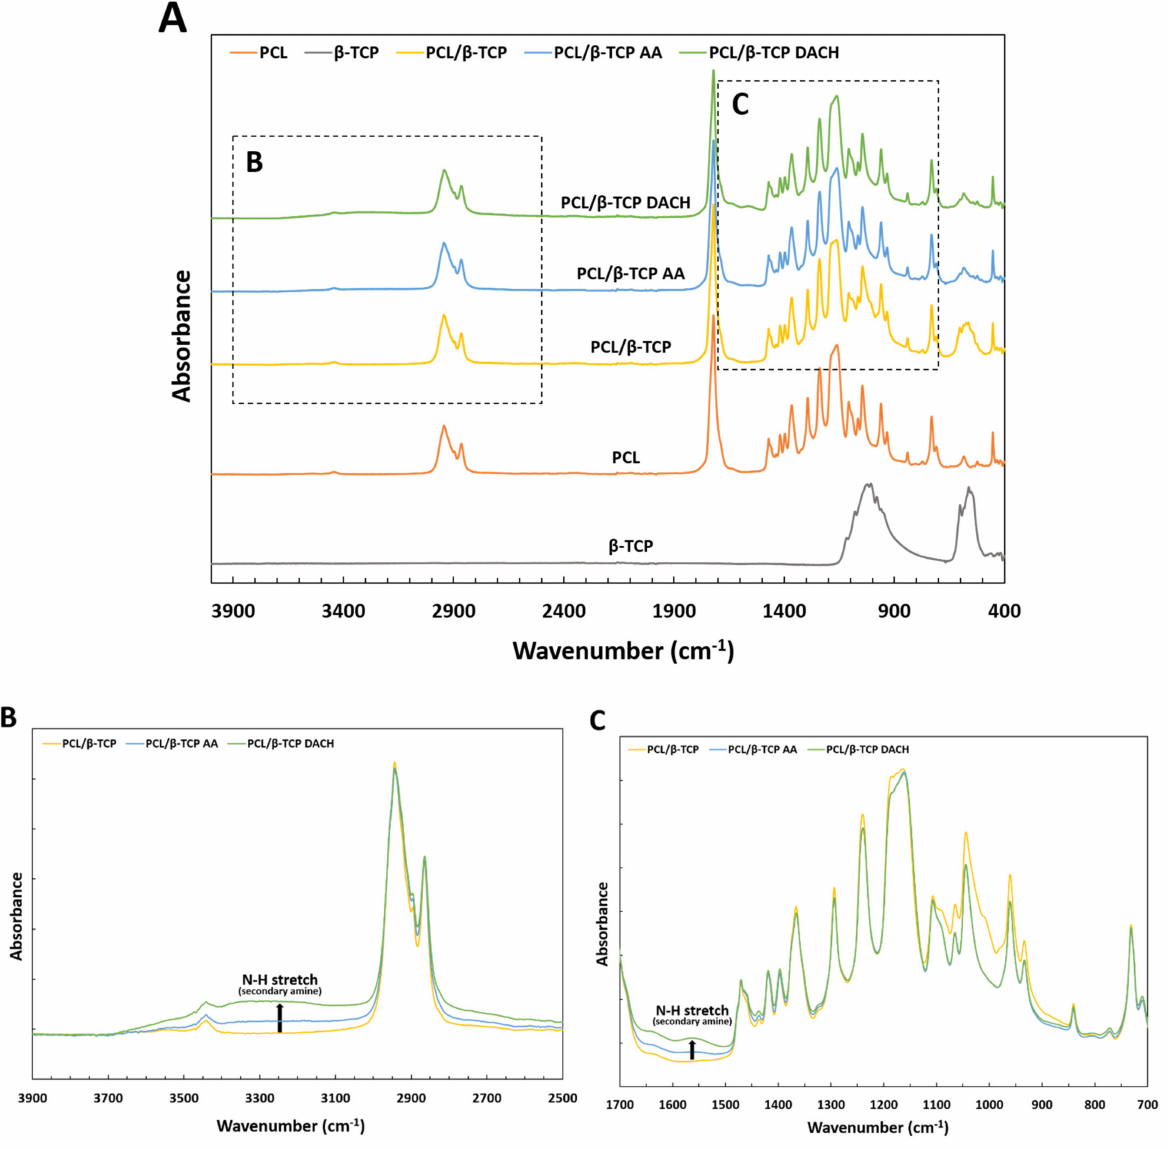
Figure 5. ( A ) FTIR spectra of β -TCP, PCL PCL/ β -TCP, PCL/ β -TCP AA, and PCL/ β -TCP DACH. ( B ) FTIR spectra of PCL/ β -TCP, PCL/ β -TCP treated AA plasma, and PCL/ β -TCP treated